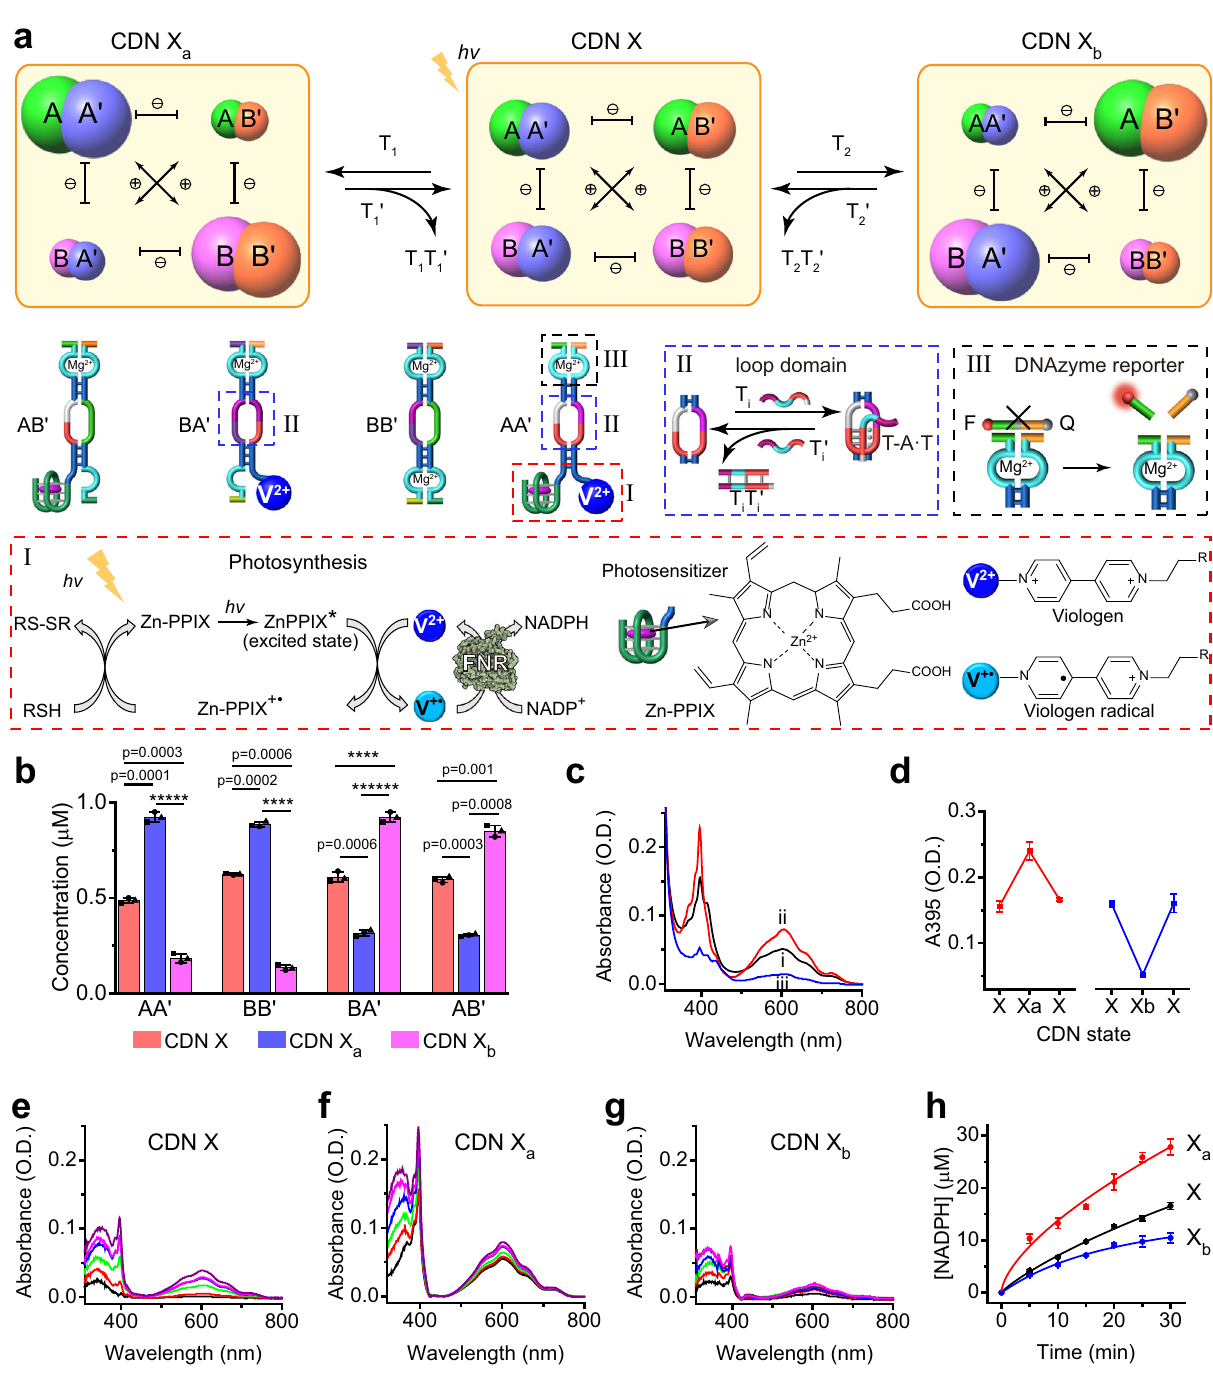
Fig. 1 Assembly and operation of the photosynthetic constitutional dynamic network (CDN). a Schematic composition of the 2 × 2 photosynthetic CDN X, its reversibly triggered transition into CDN X a or CDN X b , and the light-induced reduction of 1,4-nicotinamide adenine dinucleotide phosphate (NADP + ) into NADPH by the CDNs. Panel I-The light-induced electron transfer activated by the photosynthetic network, followed by the ferredoxin-NADP + - reductase (FNR)-biocatalyzed synthesis of NADPH, in the presence of thiol electron donor (RSH). Zn-PPIX represents the photosensitizer Zn(II)- protoporphyrin IX and V 2 + represents N,N ’ -dialkyl-4,4 ’ -bipyridinium electron acceptor. Panel II-Schematic stabilization of a constituent through the T i - triggered formation of T-A · T triplex and its destabilization by a T i ′ -induced strand displacement process. Panel III-schematic cleavage of the fl uorophore/ quencher-functionalized substrate by Mg 2 + -dependent DNAzyme reporter units associated with the constituents. b Composition of the constituents in the different recon fi gured CDNs. c Absorbance spectra corresponding to the bipyridinium radical cation (V + · ) generated by the photosynthetic network of (i) CDN X, (ii) CDN X a , (iii) CDN X b (irradiation time interval 30 min). d Switchable and reversible formation of the V + · , upon the transition CDN X → X a → X and X → X b → X. e – g Time-dependent absorbance spectra corresponding to the FNR-biocatalyzed photosynthesis of NADPH by CDNs X, X a and X b , respectively (spectra recorded at time intervals of 5 min for 30 min). h Time-dependent photoinduced generation of NADPH by CDNs X, X a , and X b . Error bars in b , d , h , represent mean ± s.d. based on three independent experiments. Two-sided unpaired Student ’ s t test ( b ), **** p < 0.0001, ***** p < 0.00001, ****** p < 0.000001. N = 3 independent experiments were performed. Source data are provided as a Source Data fi